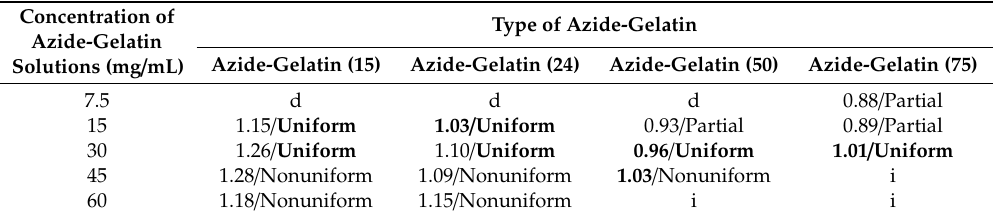
Table 2. The e ff ect of hydrogel composition on the size change of the photodegradable hydrogels on Day 7 from Day 0, and human umbilical vein endothelial cells (HUVEC) adhesion and growth. Data are presented as (size change) / (HUVEC adhesion and proliferation). Bold letters indicate the appropriate conditions for use in blood vessel tissue